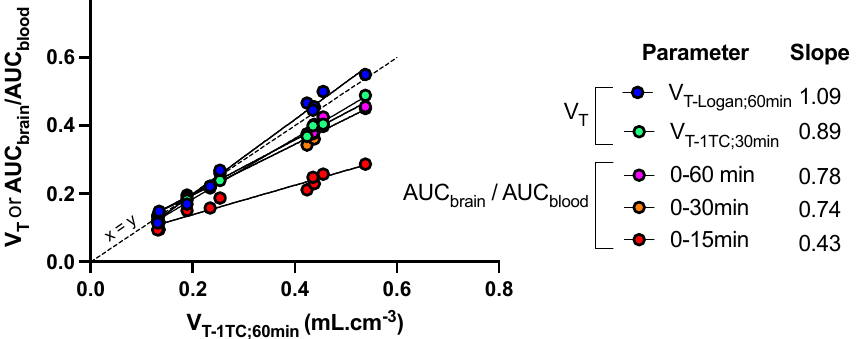
Figure 5. Sensitivity of kinetic parameters to describe the impact of FUS on the brain distribution of [ 18 F]FDS in mice. Mice ( n = 5) underwent blood-brain barrier disruption induced by focused ultrasound in the right hemisphere only. Kinetic modeling was performed to estimate the total brain distribution ( V T ) using the one-tissue compartment model ( V T-1TC ) estimated from 0 to 60 min after injection of [ 18 F]FDS. V T-1TC;0–60min values were correlated with V T-1TC estimated from 0 to 30 min (V T-1TC;0–30min ), V T estimated using the Logan graphical method from 0 to 60 min ( V T-Logan;60min ) or the ratio of the time-activity curves (AUC) measured in brain regions and blood (AUC brain /AUC blood ) from 0 to 15, 30 or 60 min. The slope of the linear correlation is